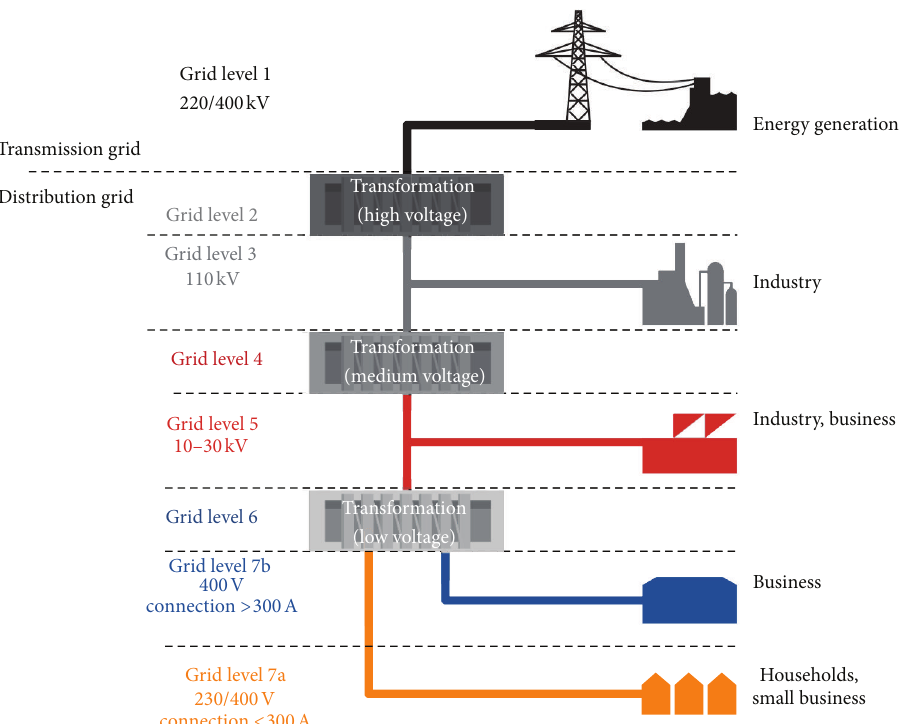
Figure 7: Hierarchy of the energy grid (source: http://www.iwb.ch/media/Strom/Dokumente/iwb factsheet netzebenen 0309.pdf).